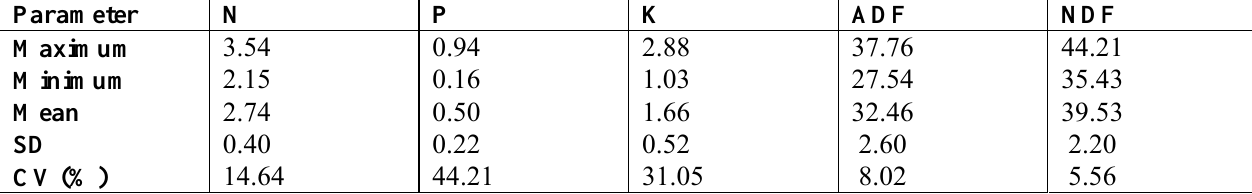
Table 1. N, P, K, ADF and NDF contents of sainfoin pasture